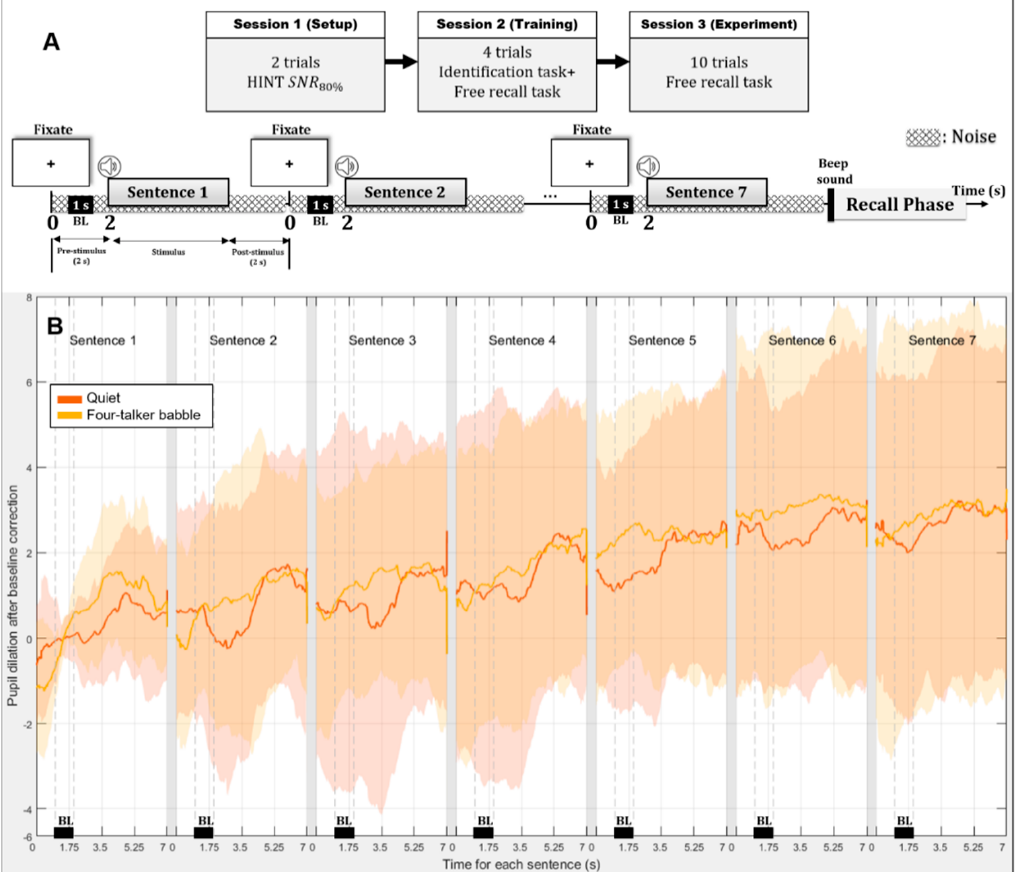
Figure 1. Outline of experimental design. ( A ) Three sessions including tasks given to each participant and encoding and recall phases used in the present study; ( B ) time course of averaged pupil dilation during the encoding phase of a seven-sentence list across participants for each listening condition (quiet or four-talker babble noise). Sentence baselines were corrected with respect to the initial-sentence baseline (sentence 1), and peak pupil dilation values were corrected using the sentence’s baseline. Pupil dilation curves: Orange, in the quiet condition; yellow, in the noise condition. Orange and yellow shaded areas indicate standard deviations. “0” represents the onset of noise used to calculate peak pupil latency. BL, 1-s baseline period during the 2-s pre-stimulus (noise-only) period.